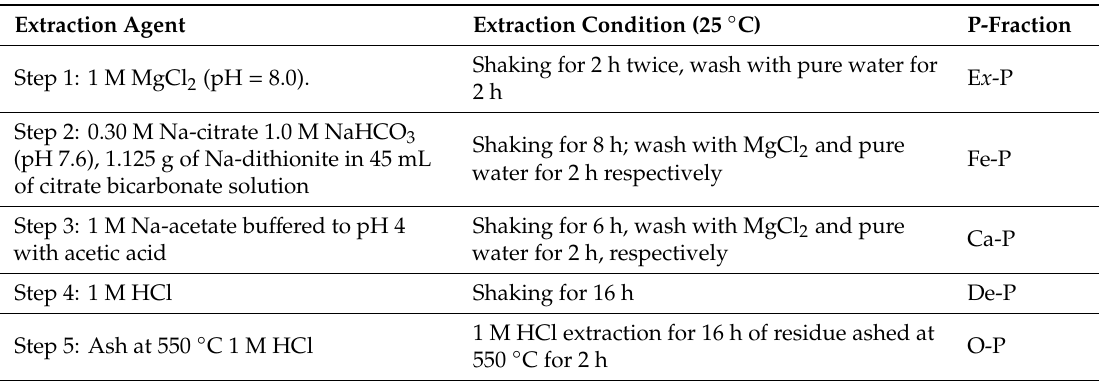
Table 1. Phosphorus fraction